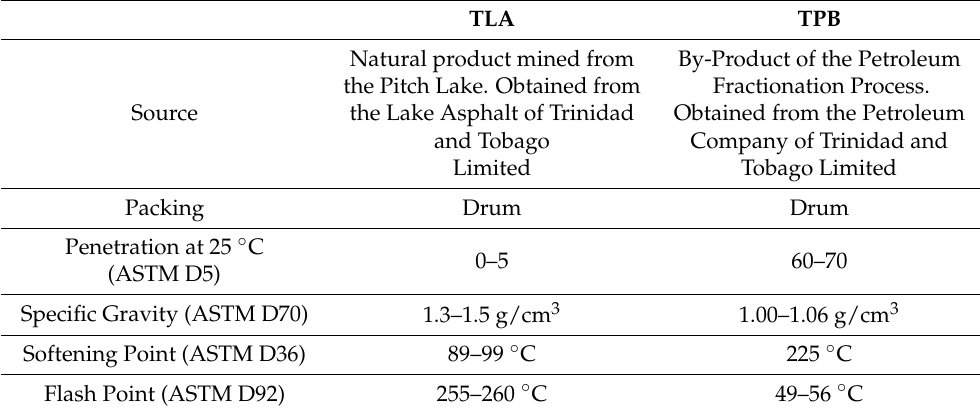
Table 1. Source and specifications of Trinidad Lake Asphalt (TLA) and Trinidad Petroleum Bitumen (TPB) samples utilized in this study [14]. TLA TPB By-Product of the Petroleum Natural product mined from Fractionation Process. the Pitch Lake. Obtained from Obtained from the Petroleum Source the Lake Asphalt of Trinidad Company of Trinidad and and Tobago Tobago Limited Limited Packing Drum Drum Penetration at 25 ◦